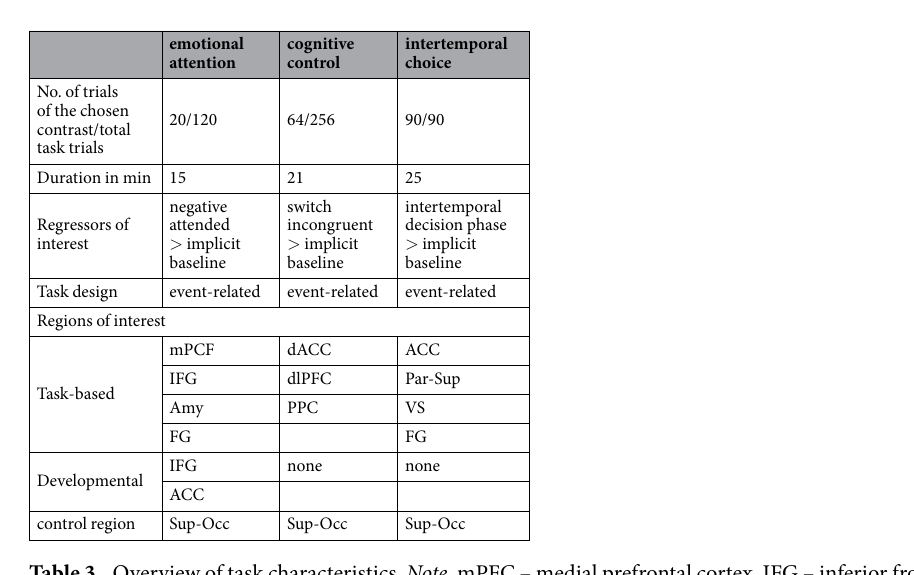
Paradigms. For an overview of the main characteristics of the three paradigms see Table 3. In the emotional attention task, participants had to decide whether a pair of visual target stimuli was identical or not while another pair was presented as a distractor. Participants were not asked to attend to a particular emotional category but cued spatially by an arrow pointing in the direction of the two stimuli. Each trial consisted of a pair of pictures from one of three emotional categories (positive, neutral, negative) and a pair of non-emotional pictures. The emotional pictures were taken from the International Affective Picture System (IAPS 58 ); and the non-emotional pictures were created by shredding the chosen IAPS pictures with GIMP (www.gimp.org). For further details see Vetter et al . 16 and Pilhatsch et al . 15 and Supplement S2. The first screen of the cognitive control task was an arrow consisting of two triangles pointing in one (left, right, up or down) direction and a red dot located either at the tip or the tail of the arrow. Participants were instructed to move a joystick in the direction indicated by the arrow or the dot. The shape of the background served as a task cue: If the background was rectangular, participants had to move the joystick in the direction of the arrow and ignore the position of the dot; conversely, if the background was circular, participants had to respond to the position of the dot while ignoring the arrow direction. Stimuli could be congruent, i.e. dot and arrow were pointing in the same direction, or incongruent, i.e. the dot and the arrow were pointing in opposite directions. For further details see Mennigen et al . 17 , Rodehacke et al . 18 . In the intertemporal choice task participants had to choose between a larger later reward, which changed from trial to trial and a fixed immediate reward, which was instructed beforehand but not shown during scan- ning. In the current paper, the contrast of interest was the phase of the presentation of the potential later reward, i.e. the intertemporal decision phase, which refers to the process of comparing both alternatives in a given trial (fixed immediate or later reward). The task started with a behavioral training session to estimate the individual